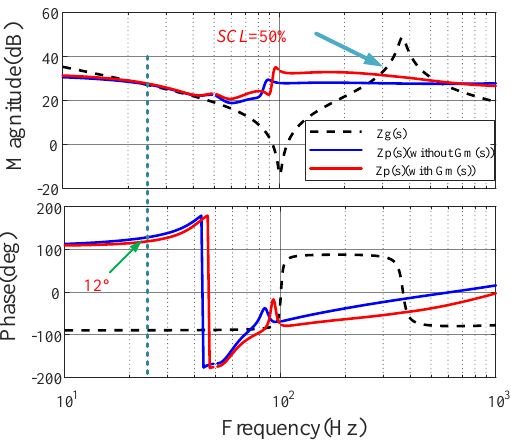
Figure 10. Impedance characteristic curve of the inverter after the current loop impedance reshaping.